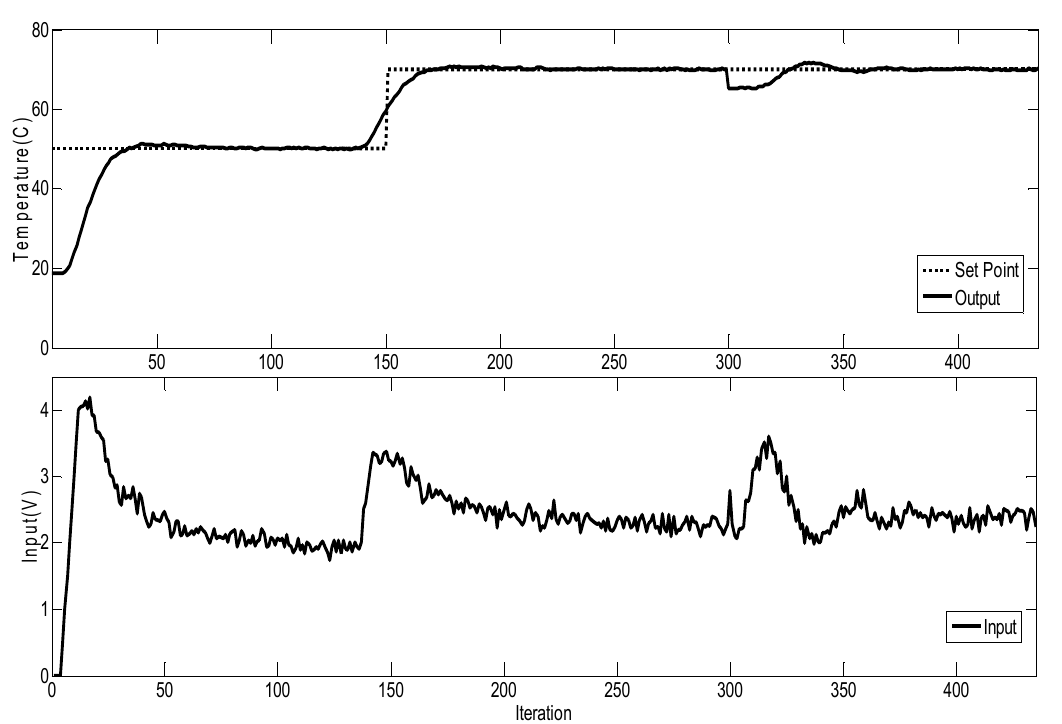
Figure 4. RFPC-GGP controller.